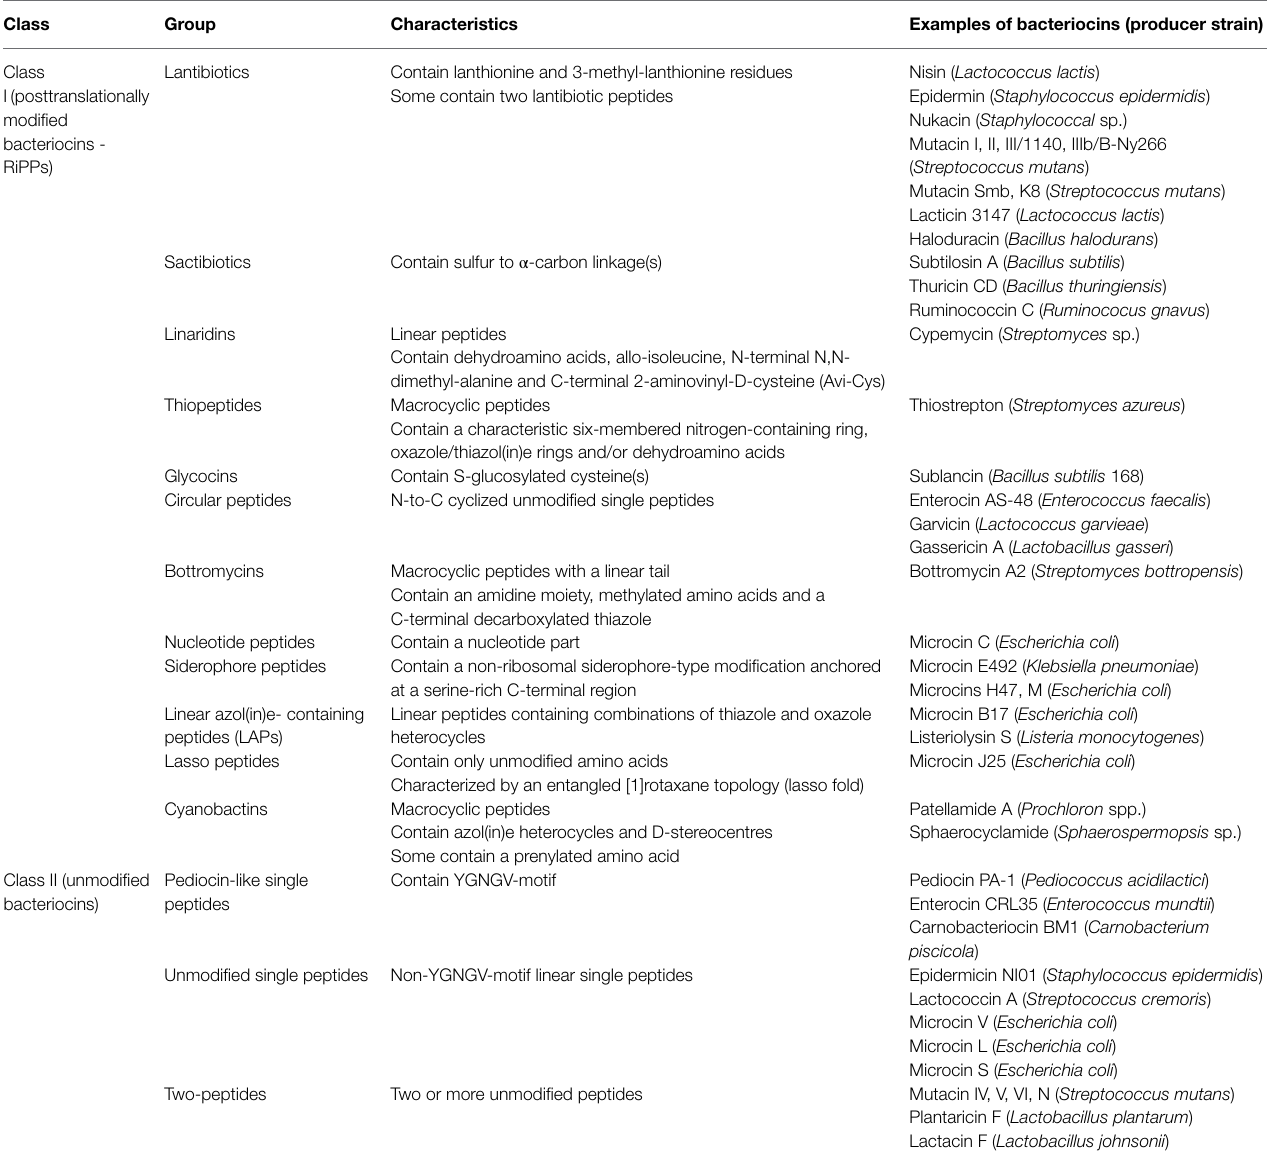
TABLE 1 | Classification of bacteriocins from Gram-positive and Gram-negative bacteria. Class Group Characteristics Examples of bacteriocins (producer